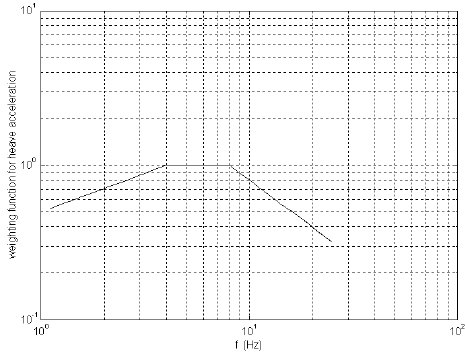
Figure 12. Frequency weighting function for heave acceleration.